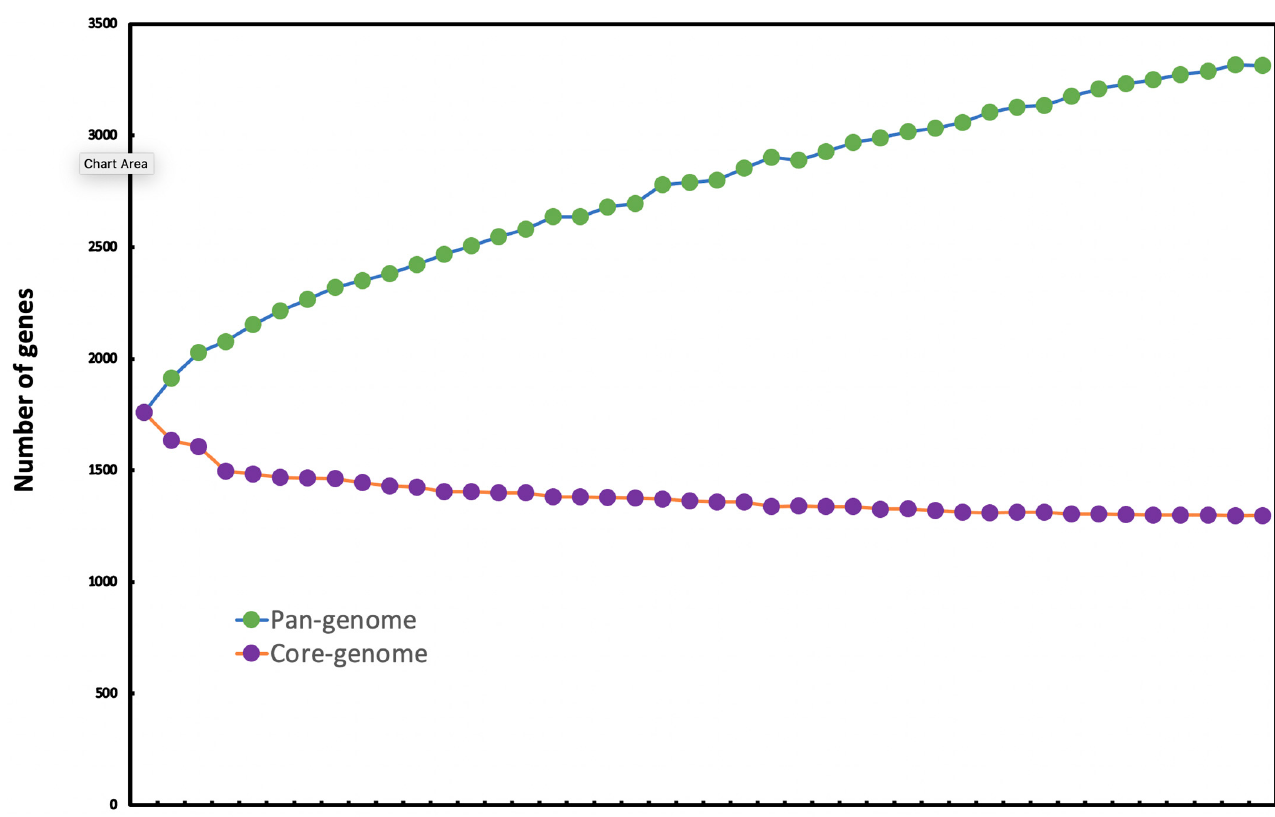
Figure 3. Pan-genome development plot of A. phocae .